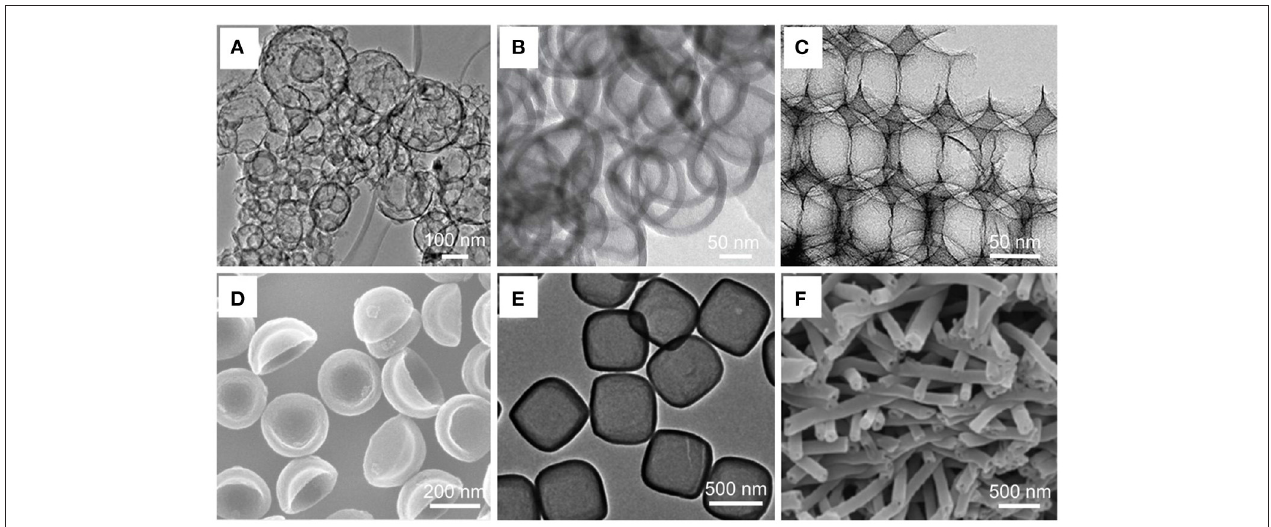
FIGURE 2 | (A) TEM image of template-free synthesized carbon hollow spheres (CHS). Natarajan et al. (2019) with permission from Royal Society of Chemistry. (B) TEM image of hollow carbon nanospheres with latex templates. Tang et al. (2012) with permission from Wiley-VCH. (C) TEM image of bicontinuous hierarchical porous carbon (BHPC-950) after hydrofluoric acid etching. Yang et al. (2017) with permission from Wiley-VCH. (D) SEM image of N-doped hollow porous carbon bowls (N-HPCB). Pei et al. (2016) with permission from Wiley-VCH. (E) TEM image of carbon nanoboxes. Yu et al. (2015) with permission from Wiley-VCH. (F) SEM image of N-doped hollow carbon nanofibers. Ramakrishnan et al. (2015) with permission from Royal Society of